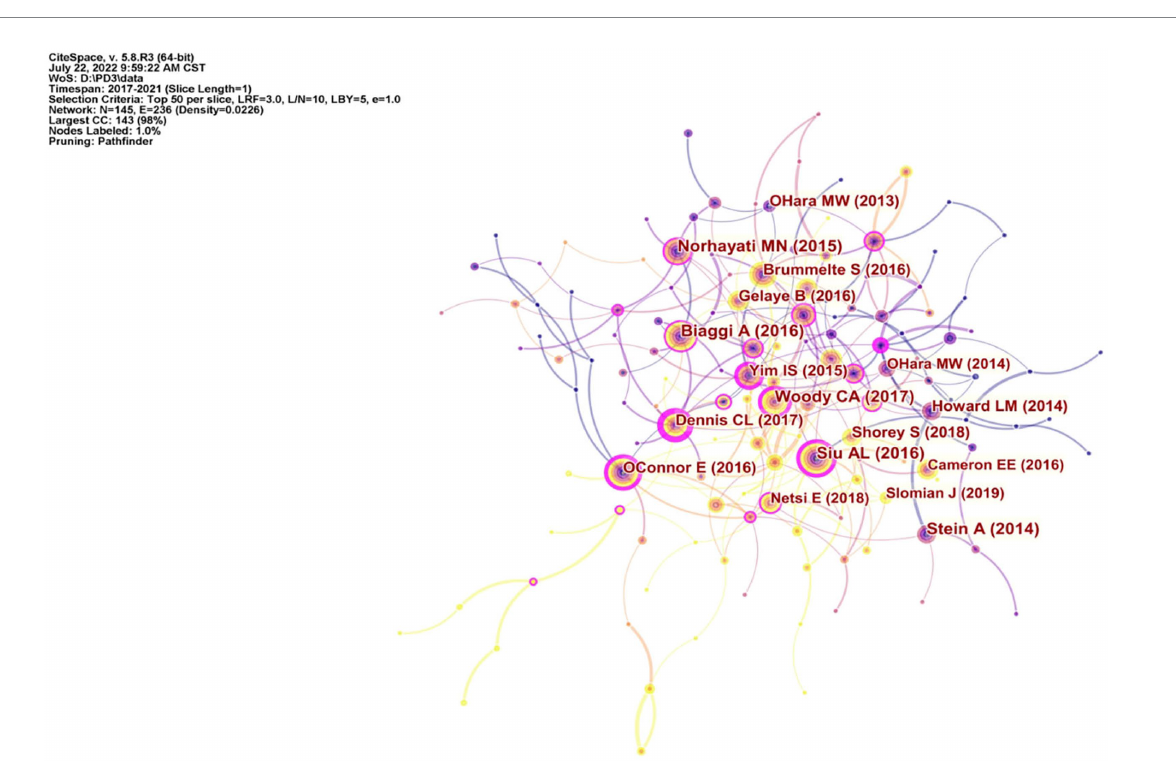
FIGURE 5 The network map of the co-cited